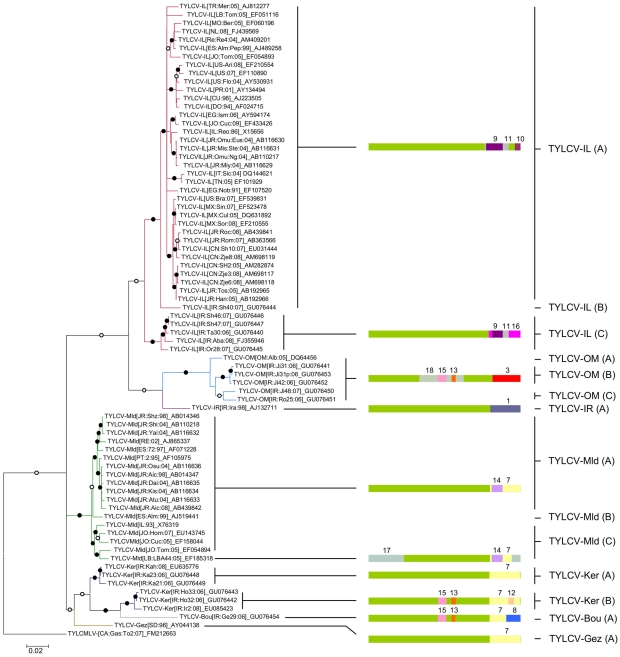
Maximum likelihood phylogenetic tree (constructed with GTR+G4 selected as the best fit model by RDP3 and rooted using a tomato yellow leaf curl Mali virus, or TYLCMV, isolate) depicting the relatedness of representative TYLCV full genome sequences.While branches supported in >90% of bootstrap replicates are marked with filled circles, those supported in >70% of replicates are marked with open circles, and those supported in <50% of replicates have been collapsed. Twelve unique recombination events yielding ten different recombination patterns are presented to the right of the tree. Whereas green colours indicate TYLCV derived sequences all other colours indicate sequences derived from non-TYLCV sources. Recombination events are numbered according to Table 1.